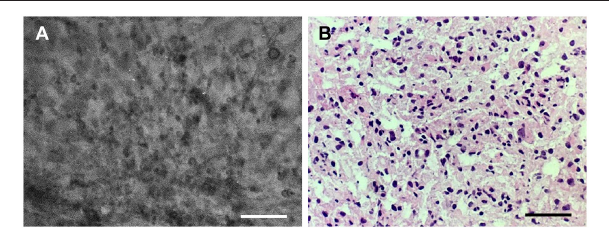
FIGURE 3 | Good correlation of the (A) confocal laser endomicroscopy image collocated with the (B) hematoxylin-eosin–stained frozen section interpreted as grade II glioma. Scale bars, 50 µ m. Used with permission from Barrow Neurological Institute, Phoenix, Arizona.